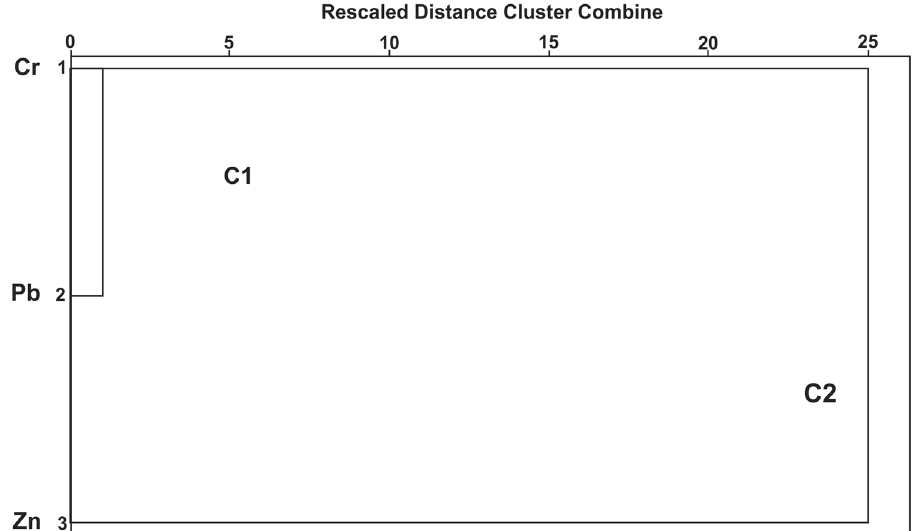
Fig. 3 Dendrogram of cluster